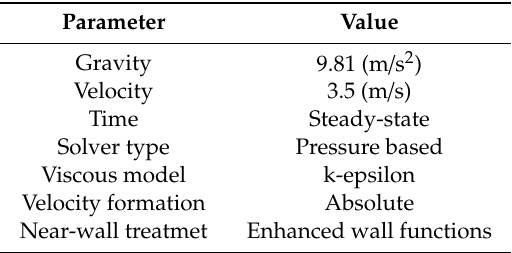
Table 8. Boundary